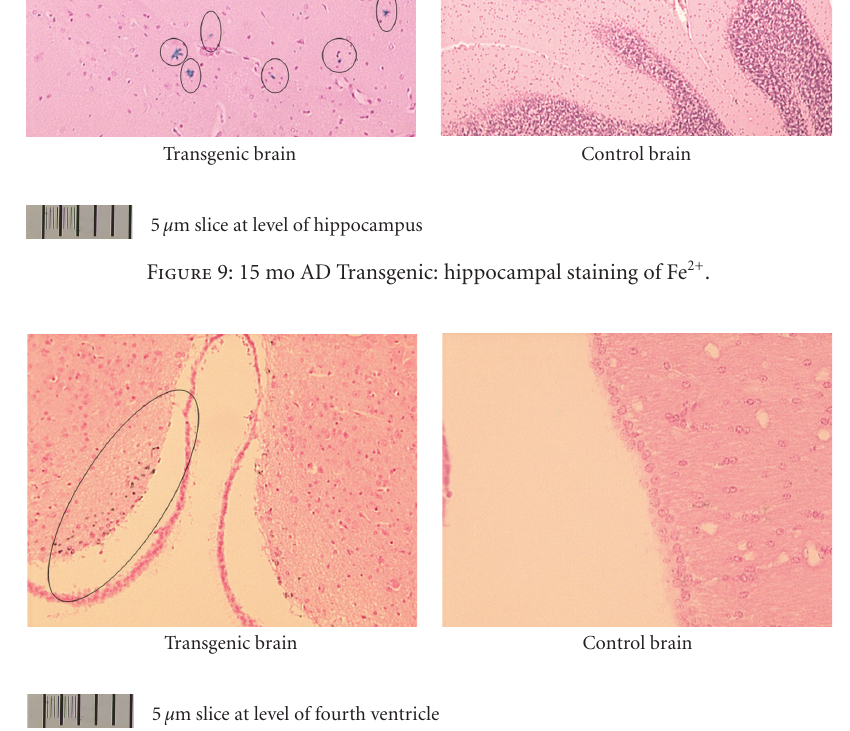
Figure 10: Cu 2+ staining of aggregates in 3 × Tg (APP/PS1/Tau)